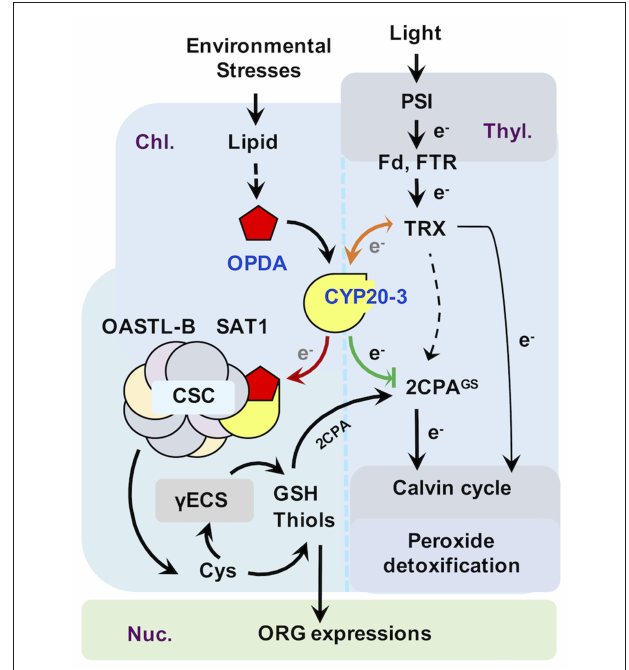
FIGURE 3 | Proposed model of CYP20-3 as a regulatory hub in the interplay between light and OPDA signaling. In optimal conditions, CYP20-3 relays light signaling in buffering cellular redox homeostasis, whereas, in stressed states, CYP20-3 interfaces light and OPDA signaling, which fine-tunes plant fitness between growth (light-dependent detoxification and Calvin cycle) and defense response (redox-mediated retrograde signaling). Colored arrows indicate the enhanced interactions of CYP20-3 with TRXs (orange), SAT1 (red), and 2CPA (green) during stress (OPDA-signaling) defense responses. Hypothesized passage of electron (e − ) transfers is noted in